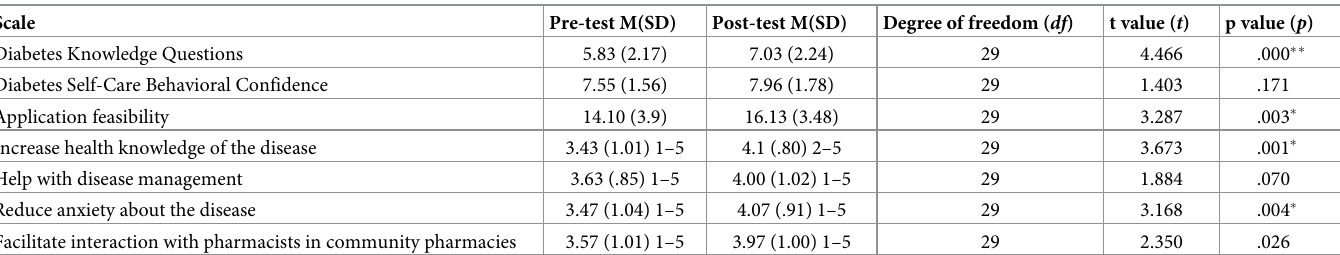
Table 4. Summary of paired t-tests for diabetic patients on pretest-posttest changes in interactions with health care robots a-d